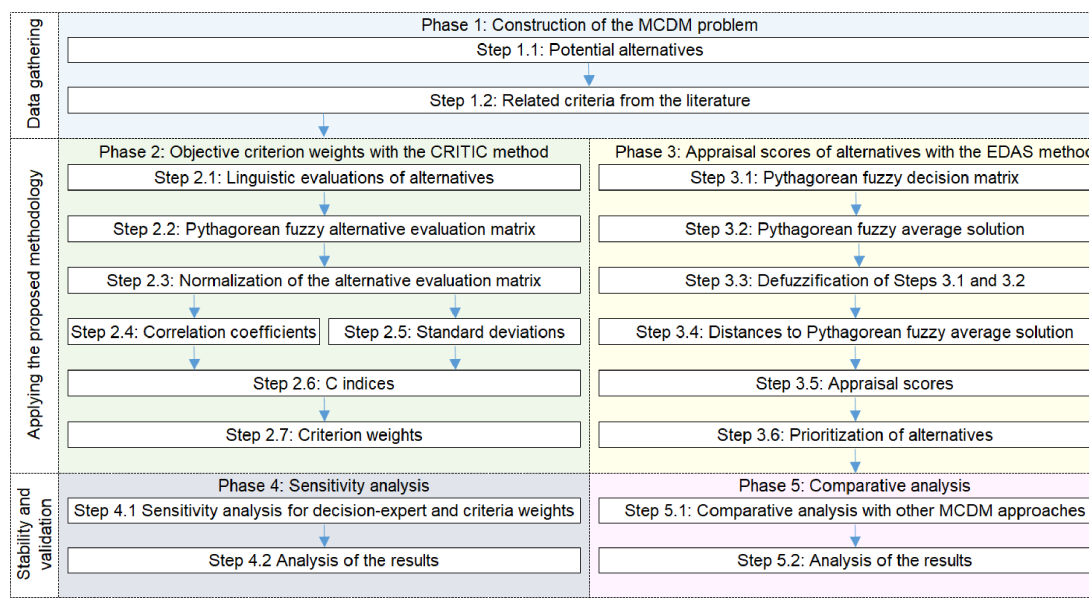
Fig 1. Evaluation of AM processes with MCDM methods in the